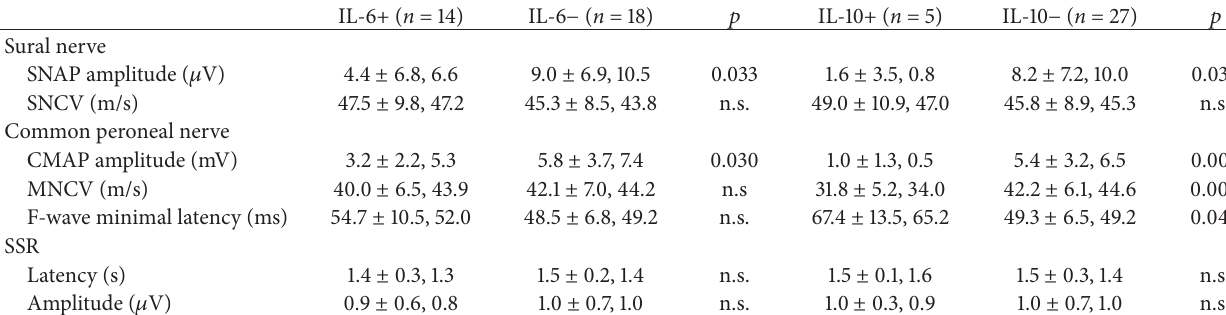
Table 2: Electrodiagnostic measures.